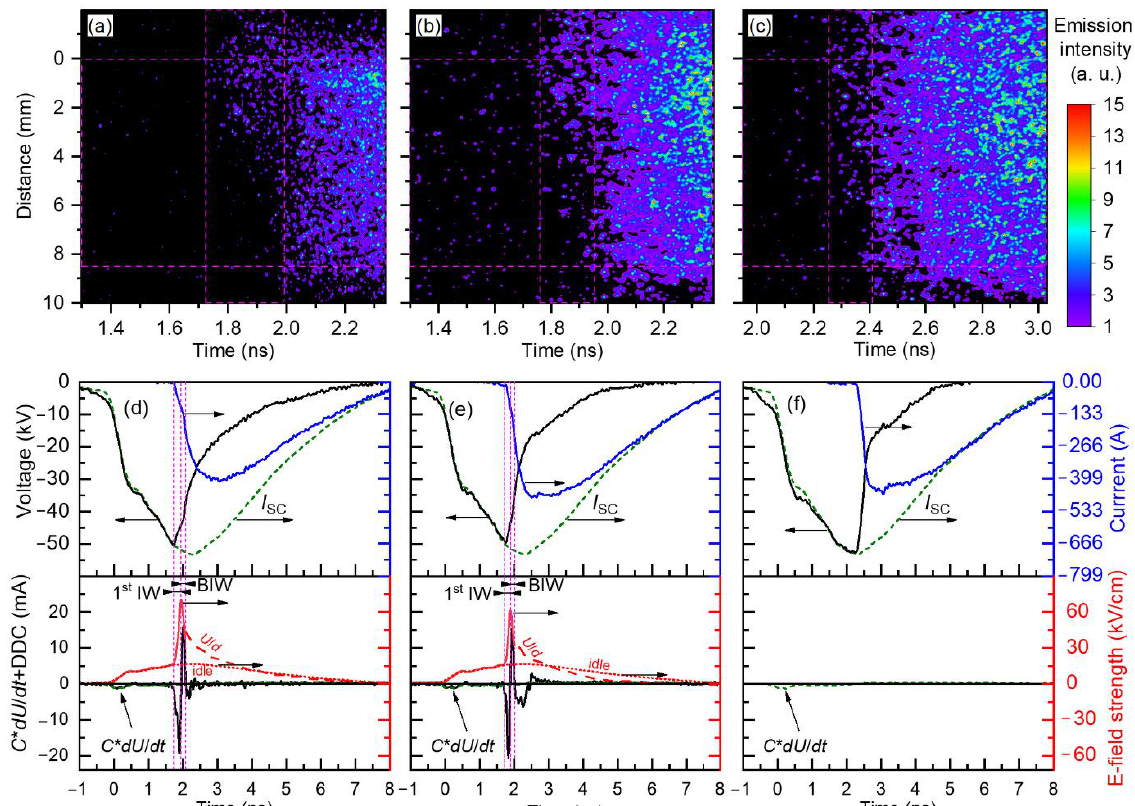
Figure 6. ( a – c ) Streak-images of the discharge formation dynamics and ( d – f ) corresponding waveforms of voltage, U gap , current, I d , displacement current ( C gap dU gap / dt + DDC) measured with the collector placed downstream the grounded grid electrode, and the electric field strength (calculated) near the surface of the grounded electrode at various air pressures. 1st IW — first ionization wave (streamer), BIW — backward ionization wave.